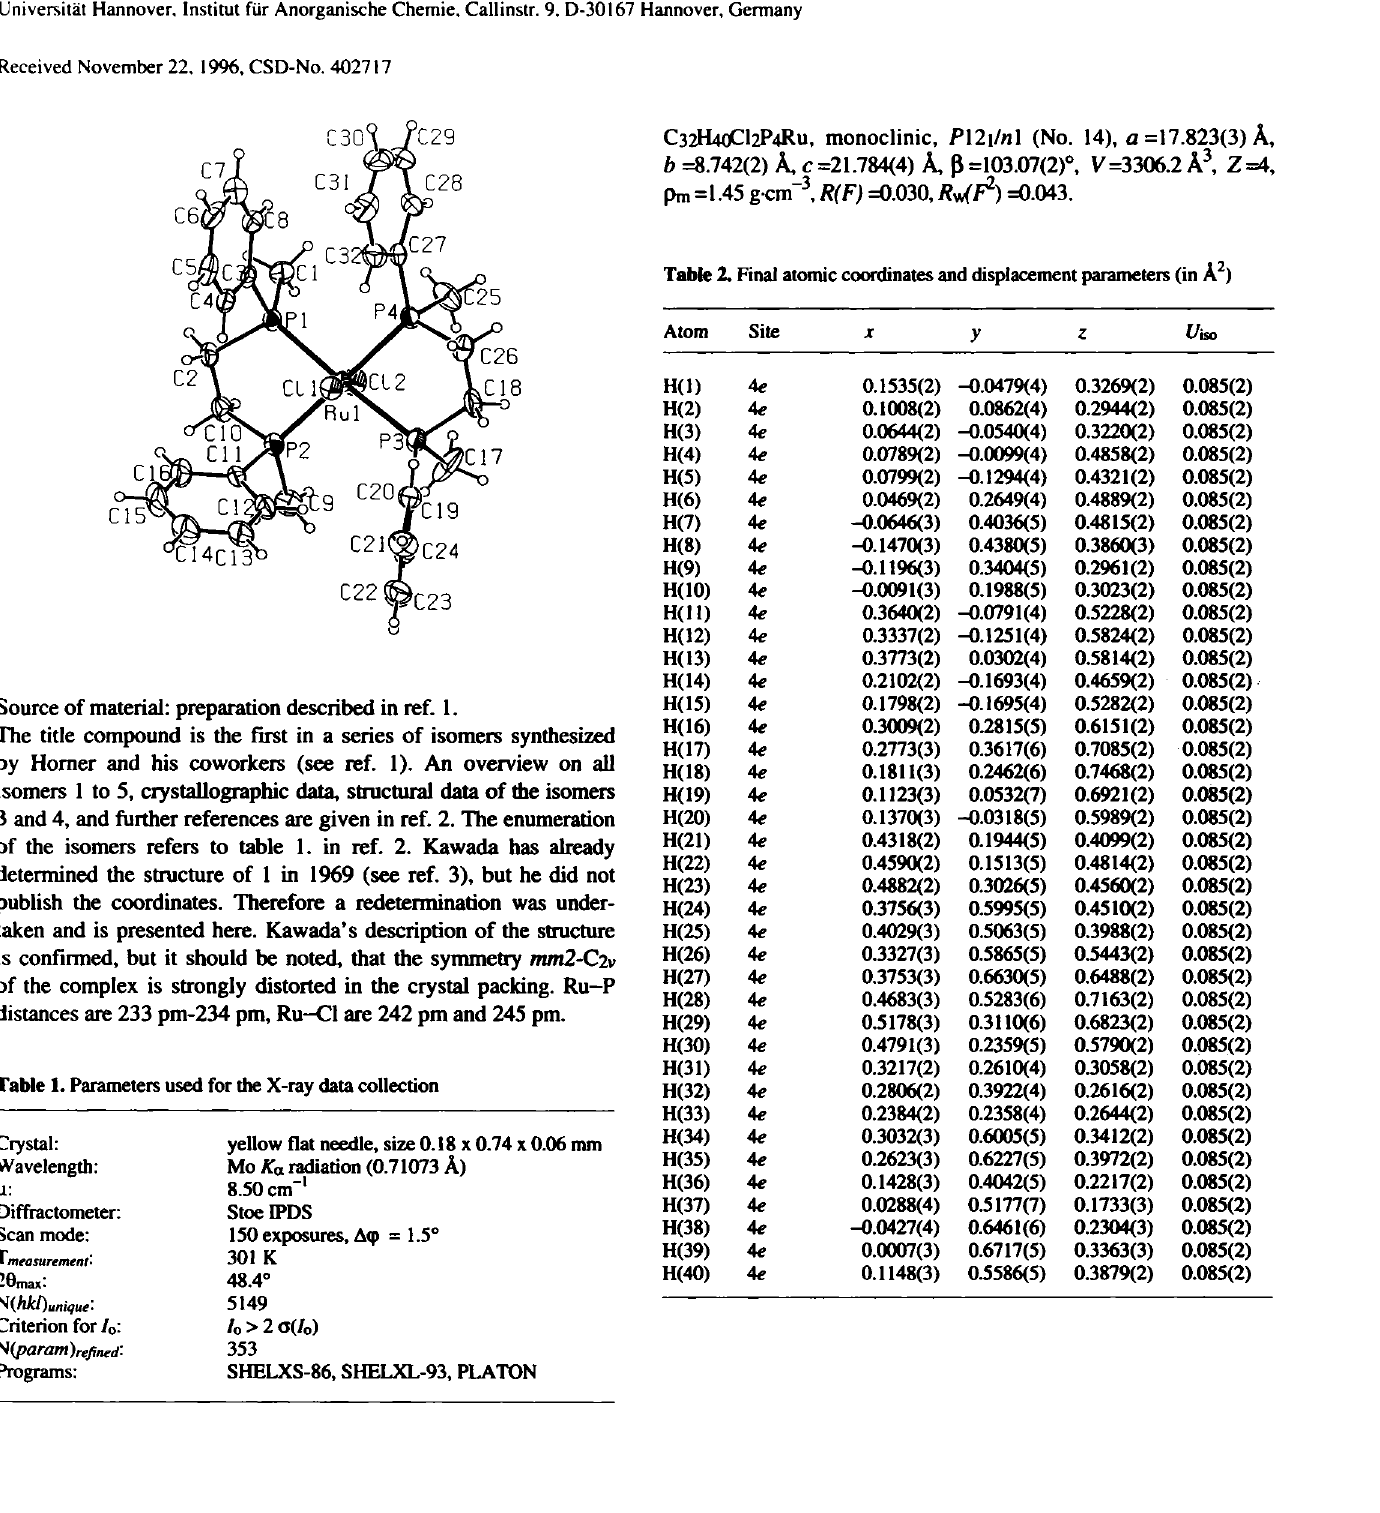
Table 2. Final atomic coordinates and displacement parameters (in A 2